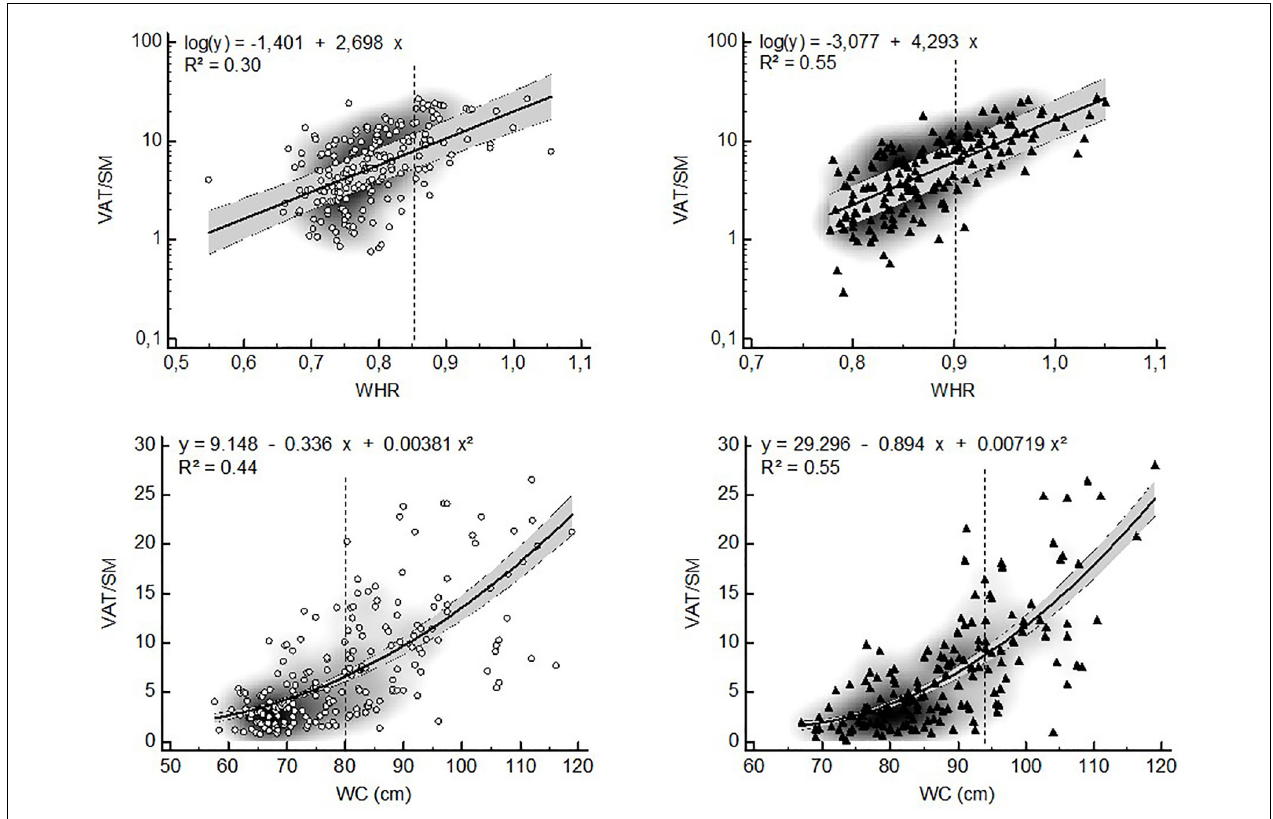
FIGURE 4 | Non-linear relationships between the VAT/SM ratio and anthropometric estimates of visceral adiposity ( (cid:78) = women, (cid:78) = men, VAT = visceral adipose tissue, SM = skeletal muscle, WHR = waist-to-hip ratio, WC = waist circumference, dashed lines represent WHO (25) cut points for increased cardiometabolic risk in whites, gray zone represents 95% confidence